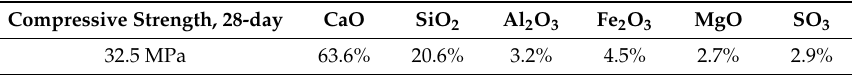
Table 2. Physical properties and chemical compositions of